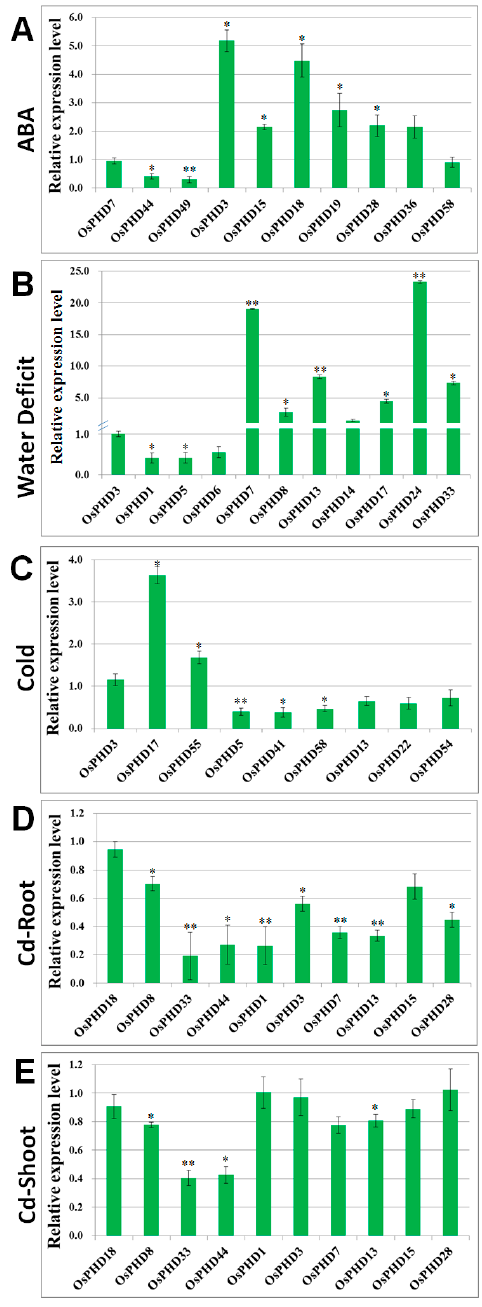
Figure 9. Quantitative real-time PCR validation of OsPHDs under ABA ( A ); water deficit ( B ); cold ( C ); Cd-root ( D ) and Cd-shoot ( E ) stresses. For ABA and Cd treatments, the three-week-old rice seedlings were treated with 50 µM ABA or 50 µM Cd for 24 h. For cold stress, rice seedlings were exposed to 4 °C for 24 h. For water deficit stress, water irrigation was stopped until the soil water content was decreased to 40% of that under normal conditions. For each stress treatment, one OsPHD gene whose expression was not affected by this stress, was used as a reference for qRT-PCR assays. OsEf1- α (elongation factor 1- α ) was used as an internal reference. The mean values (±SE) from three fully independent biological repeats and three technical repeats are shown. Asterisks indicate significant differences (* p < 0.05; ** p < 0.01 by Student’s t -test).